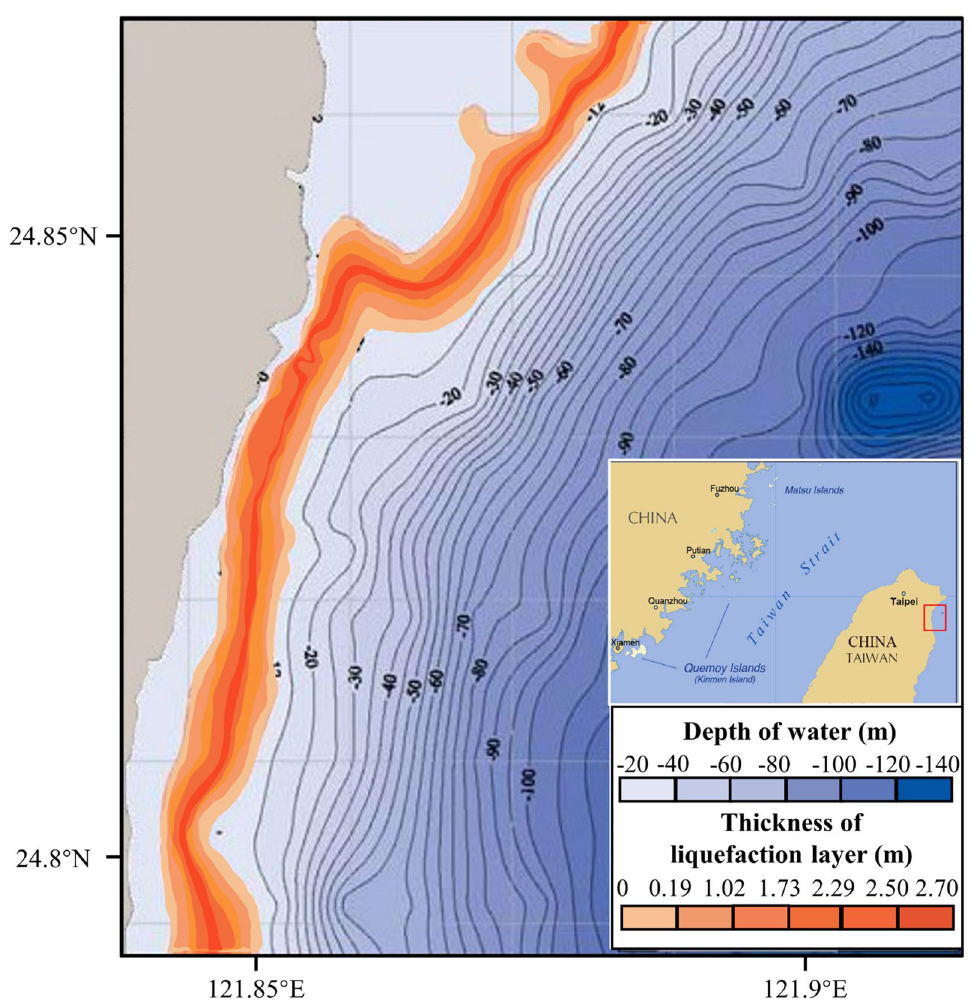
Fig. 12 The susceptibility zone map for the coastal area of Yilan, Taiwan Province, China (modified from Chang et al.